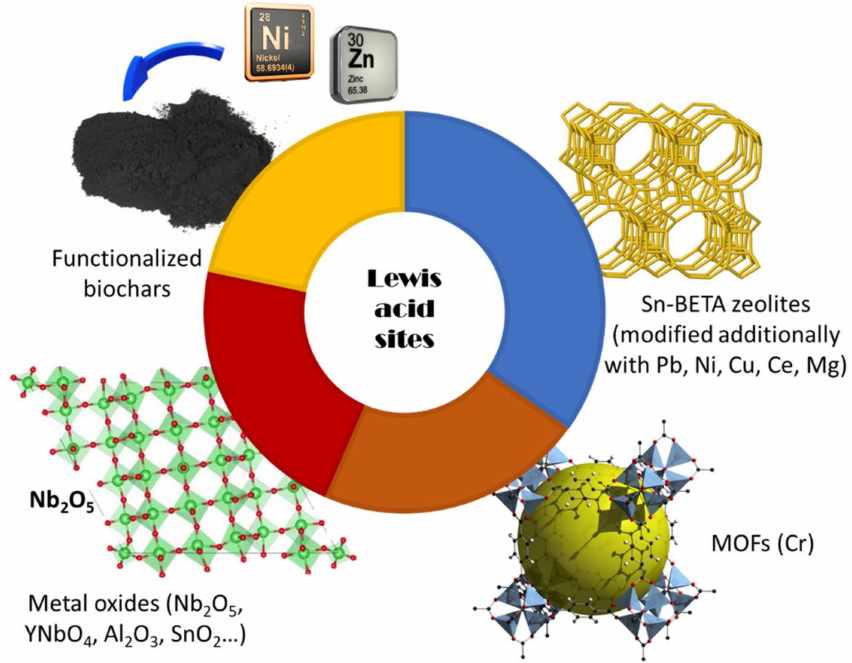
Figure 4. Involved sites and most studied catalysts for glucose/fructose transformation to lactic